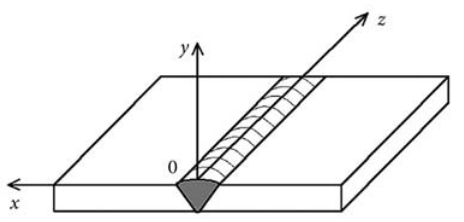
Fig. 11. Temperature distribution fields after 56 s from welding simulation has started